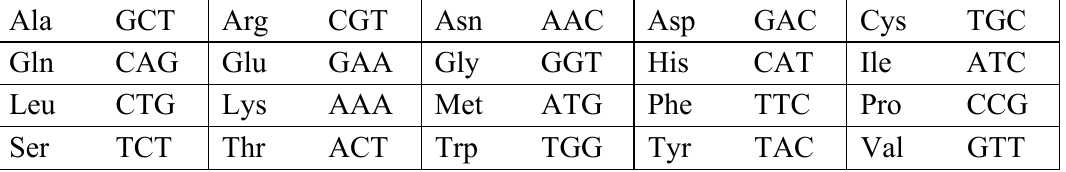
Table 4. List of codons recommended for the trinucleotide approach by Kayushin et al .